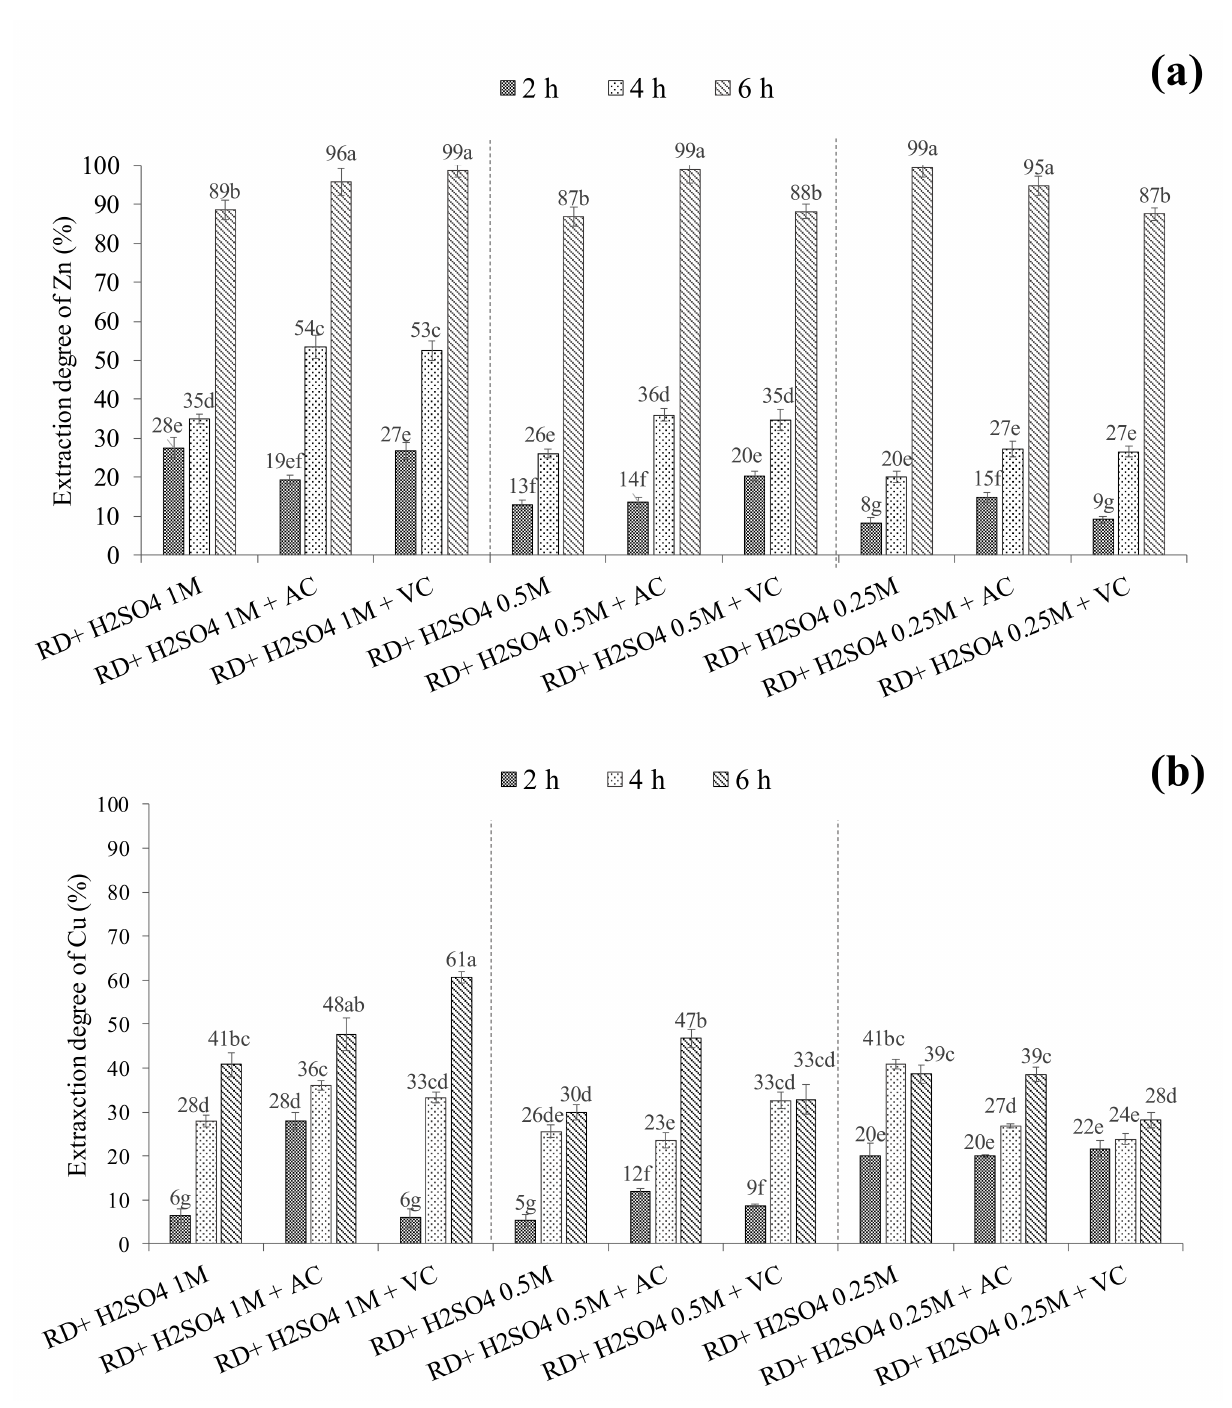
Figure 1. Extraction degree of Zn ( a ) and Cu ( b ) after 4 h and 6 h. Values in column for each hour followed by the same letter are not significantly different ( p = 0.05) using the Duncan test with a R 2 = 0.98 (a) and R 2 = 0.98 (b). Error bars indicate standard errors of the mean (n =